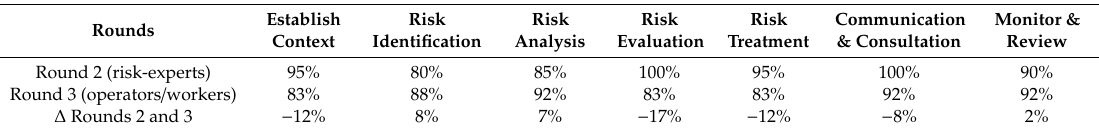
Table 3. The proportion of participants (risk-experts, operators / workers) who approved the PEIs across round two and three of a Delphi technique.